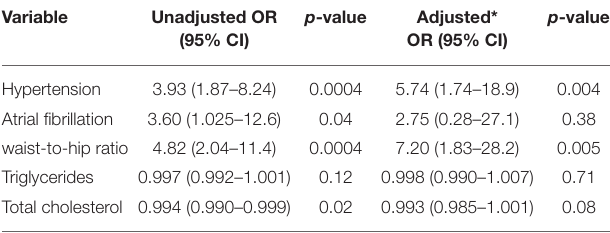
TABLE 1 | Comparison of baseline characteristics and risk factors. TABLE 2 | Predictors of presumed large vessel occlusion.